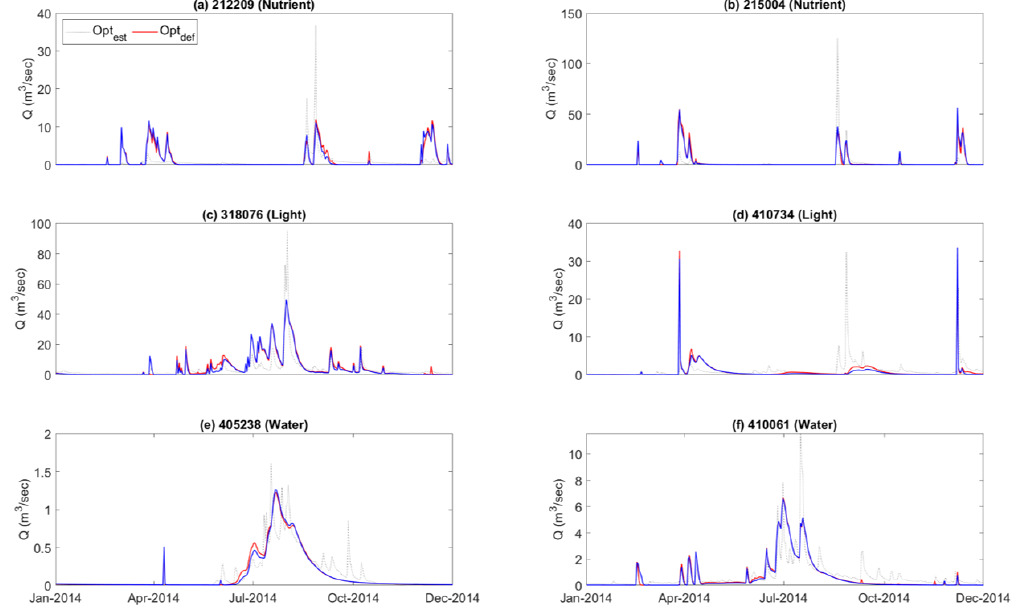
Figure 5. 1-year time series of daily Q observed (black dotted-line) and simulated by Opt def (blue continuous line) and Opt est (red continuous line) respectively for six selected catchments: ( a ) 212209, ( b ) 215004, ( c ) 318076, ( d ) 410734, ( e ) 405238 and ( f ) 410061.